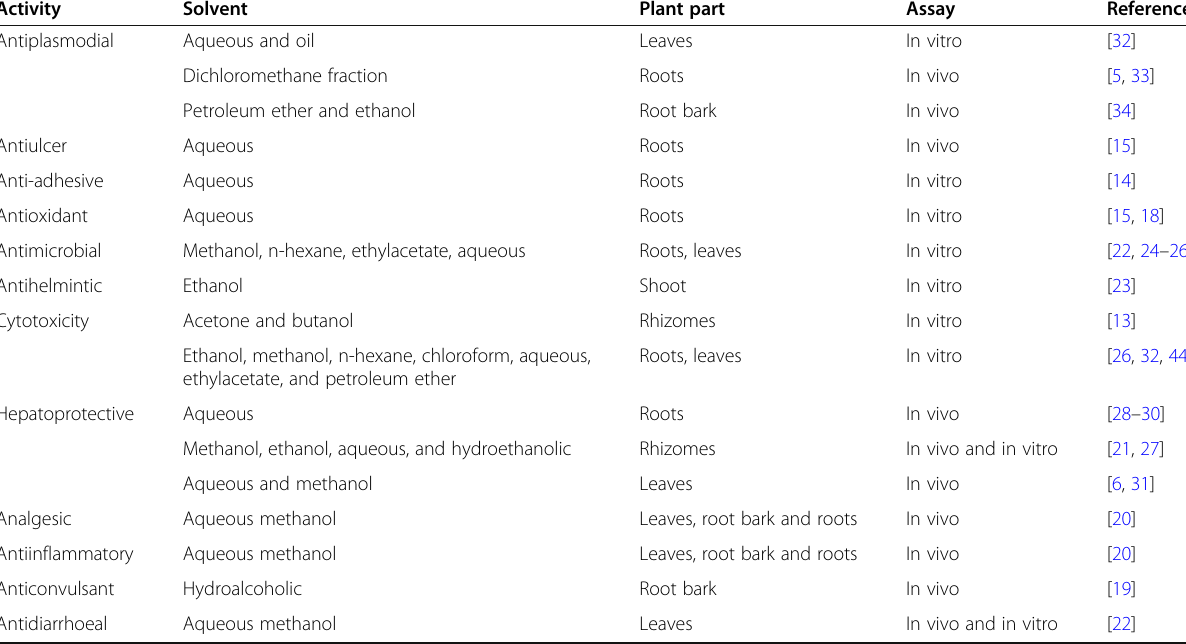
Table 3 Pharmacological activities of various extracts of Cochlospermum tinctorium